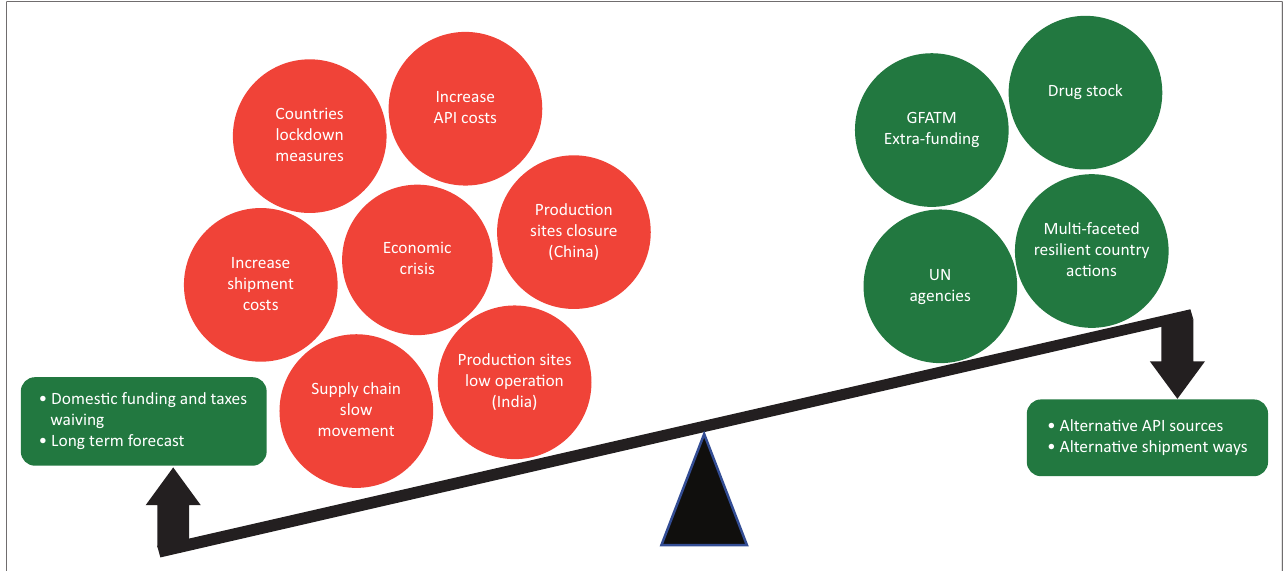
FIGURE 1: Challenges and solutions in the medication supply chain under coronavirus disease 2019